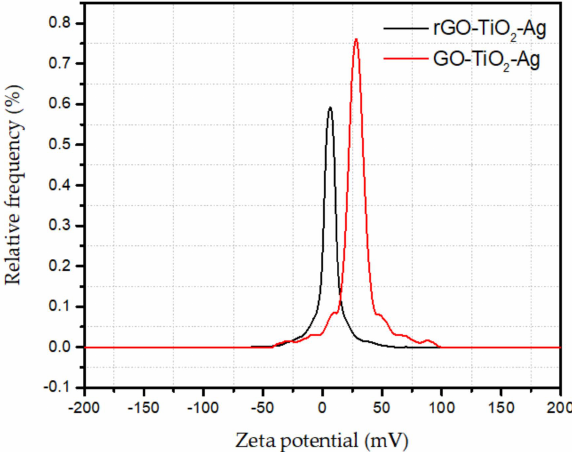
Figure 1. Zeta potential of ternary hybrid